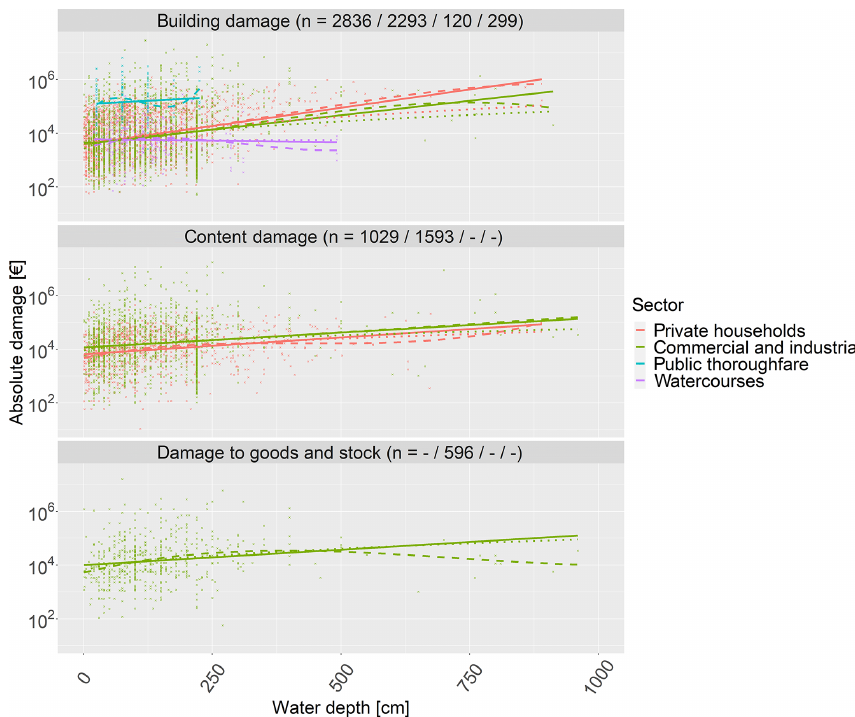
Figure 7. Depth–damage curves for all four economic sectors (private households, commercial and industrial, public thoroughfare, water- courses) and damage types (building damage, contents damage, damage to goods and stock) currently available in HOWAS 21. Solid line: linear regression; dashed line: polynomial regression; dotted line: square-root regression. Absolute damage values are plotted on the loga- rithmic scale. The numbers in brackets in the plot titles are the sample sizes of the datasets, whereby the order of numbers corresponds to the order of elements in the plot